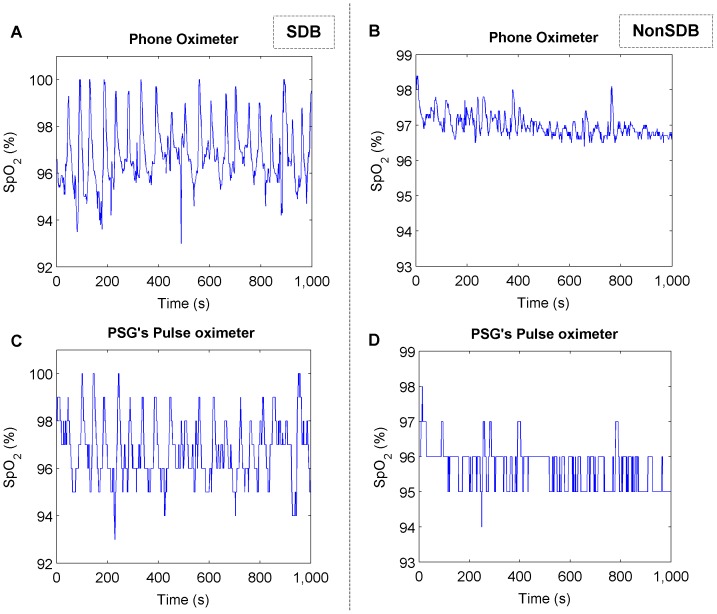
SpO2 signal with different resolutions.An SpO2 signal segment, recorded using the Phone Oximeter (0.1% resolution) for (A) SDB and (B) NonSDB children, and the corresponding SpO2 signal recorded simultaneously with the PSG's pulse oximeter (1% resolution) for the same SDB (C) and NonSDB (D) children. The SpO2 resolution has a great influence in regularity measures like approximate entropy and Lempel-Ziv [41]. Therefore, SpO2 resolution should be taken into account when studying the SpO2 pattern in children with SDB.The SpO2 randomness shown for NonSDB children in 0.1% resolution SpO2 signal (provided by the Phone Oximeter), is not reflected in the 1% resolution SpO2 signal (provided by the PSG's pulse oximeter) because of the rounding effect. This resolution difference might be the reason why children with SDB showed a higher complexity than NonSDB children with conventional pulse oximeter.